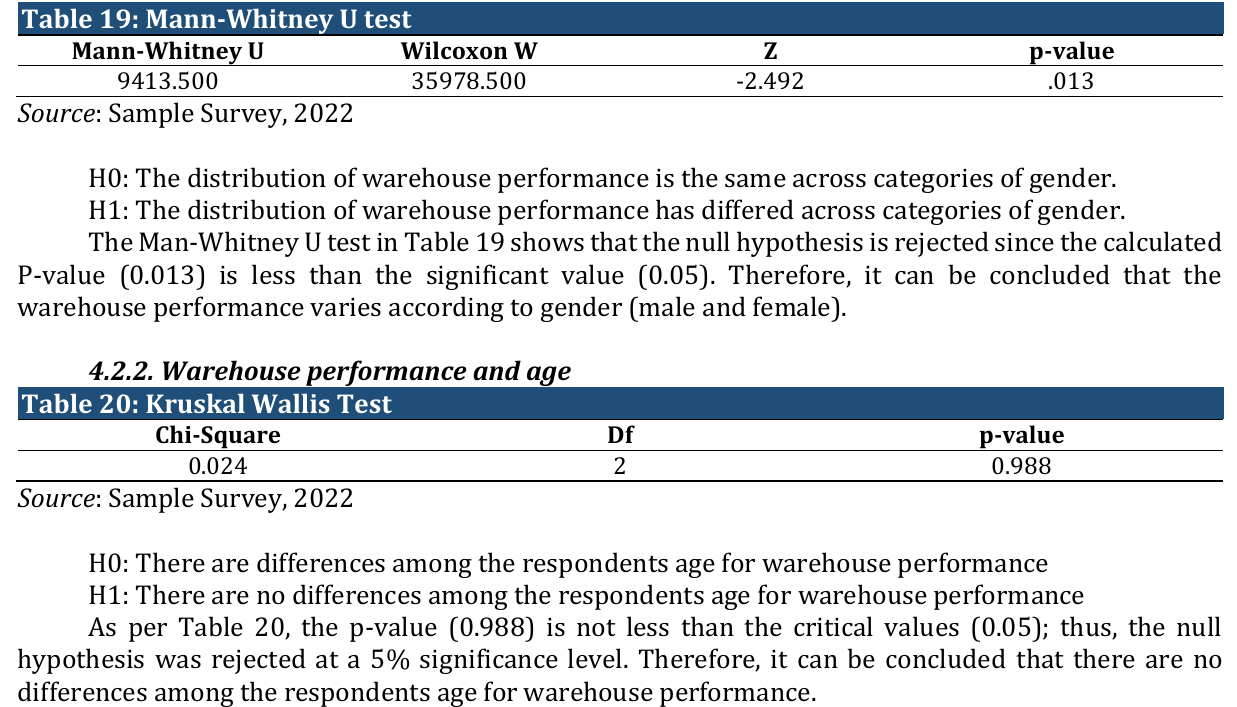
Source : Sample Survey, 2022